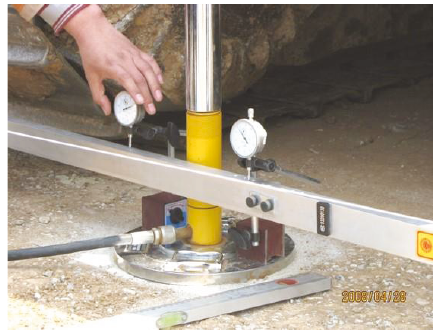
Figure 8: Plate loading test ( K